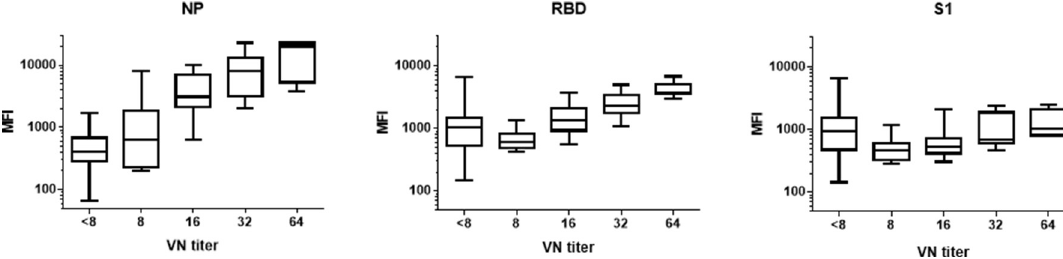
Fig 2. Correlation of virus neutralization titers with COVID-19 multiplex results using NP, RBD and S1 antigens. The SARS-CoV- 2 antigens were expressed in mammalian cells as IL-4 fusion proteins, and the three antigens were multiplexed. Serum samples included samples taken pre-COVID-19 (n = 7), obtained from healthy people in the first week of June 2020 (COVID-19 HVC, n = 50), and from convalescent patients (n = 51). The correlation coefficients, r sp , for NP, RBD and S1 were 0.726, 0.436, and -0.055,